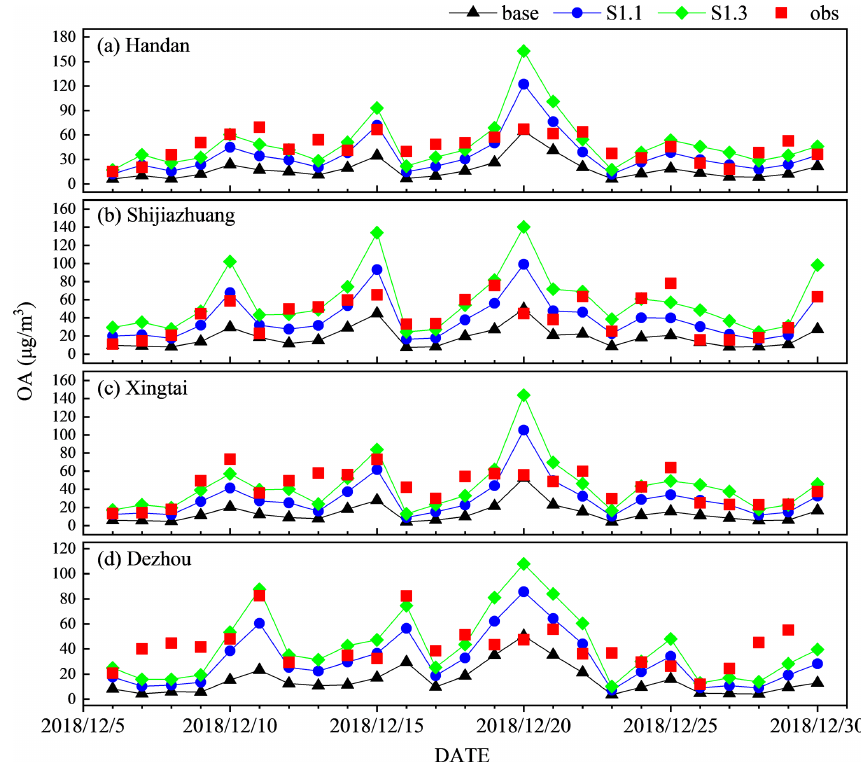
Figure 7. The observed and simulated daily OA concentrations at (a) Handan, (b) Shijiazhuang, (c) Xingtai, and (d) Dezhou from 6 to 30 December